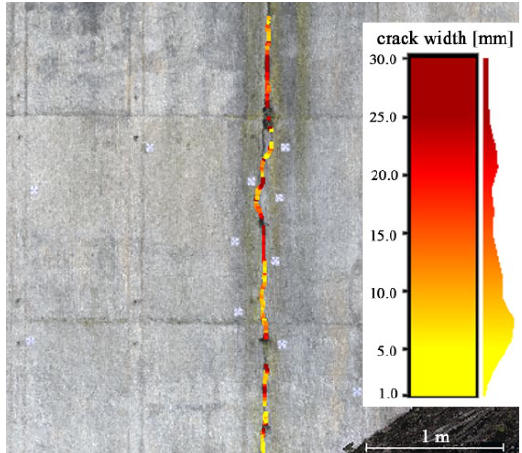
Figure 13 . 3D skeleton point, colorized based on the estimated crack width. The skeleton points are superimposed to the photogrammetric point cloud as reference. Next to the colorbar, the histogram shows the distribution of the estimated width values.